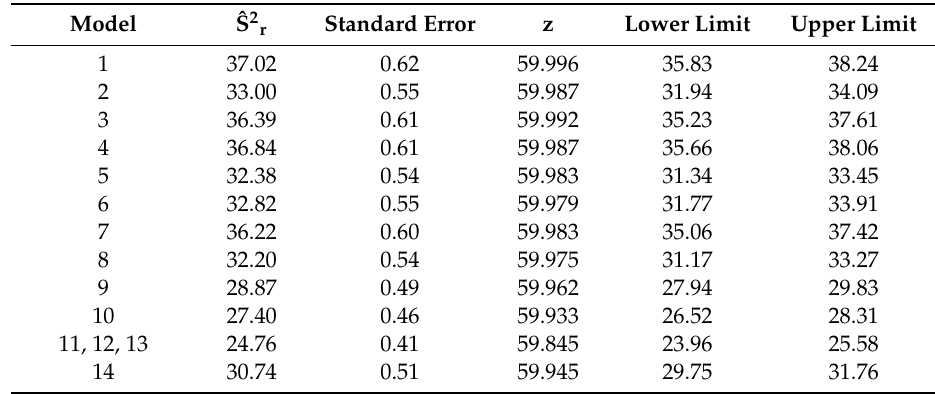
Table 4. Values of the estimated residual variance (ˆS 2 r ) of each model, its standard error, the value of the statistic (z), and the values of the lower and upper limits of the 95% confidence interval of the estimated residual variance. The p -value of the significance test was < 0.001 in all models.